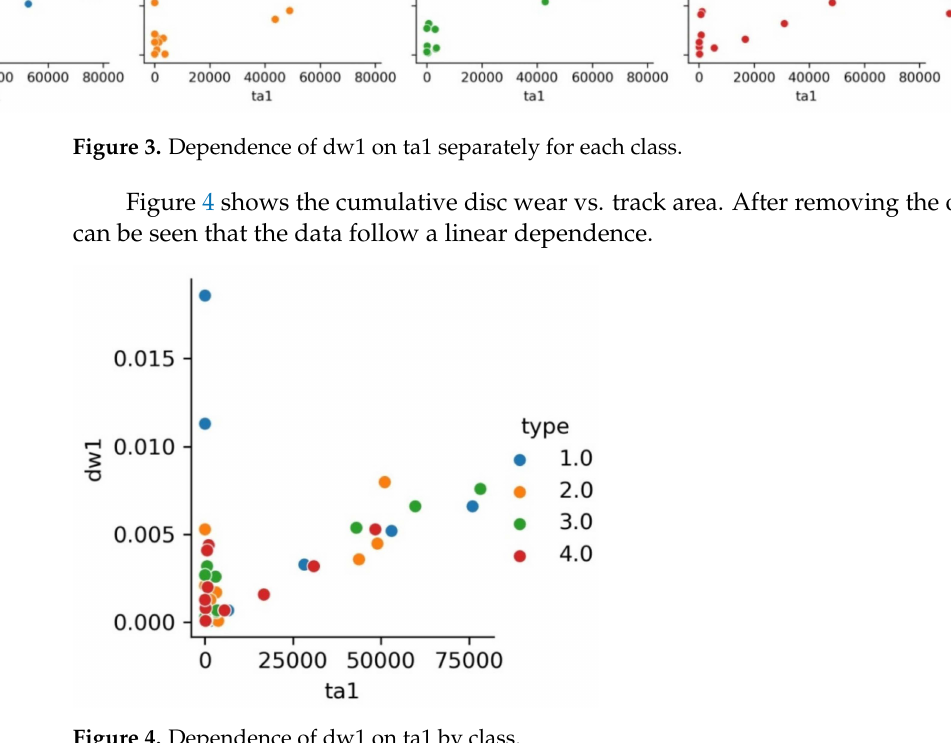
Figure 4. Dependence of dw1 on ta1 by